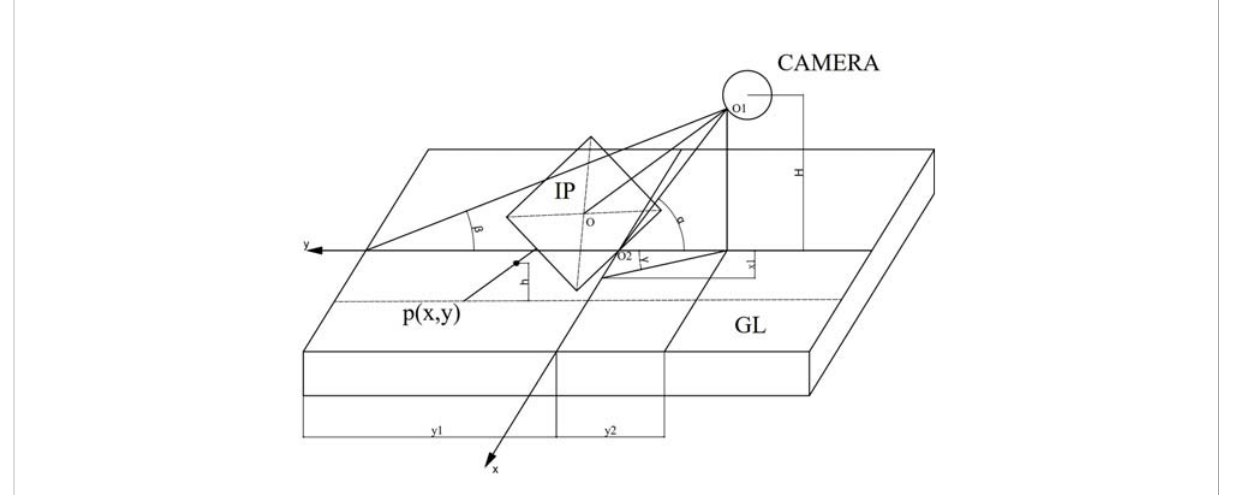
FIGURE 5 Single visual distance schematic diagram.